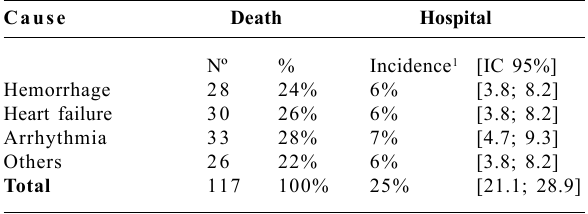
Table 2. Causes of post-operative deaths in 465 patients submitted to PLV